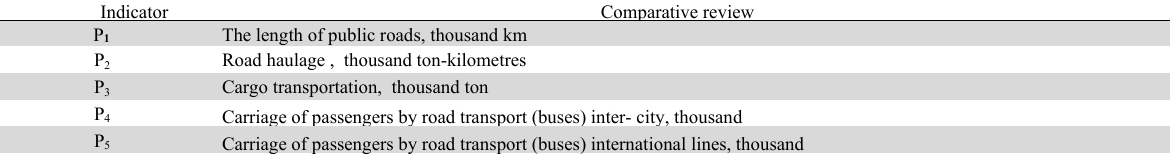
Carriage of passengers by road transport (buses) international lines, thousand